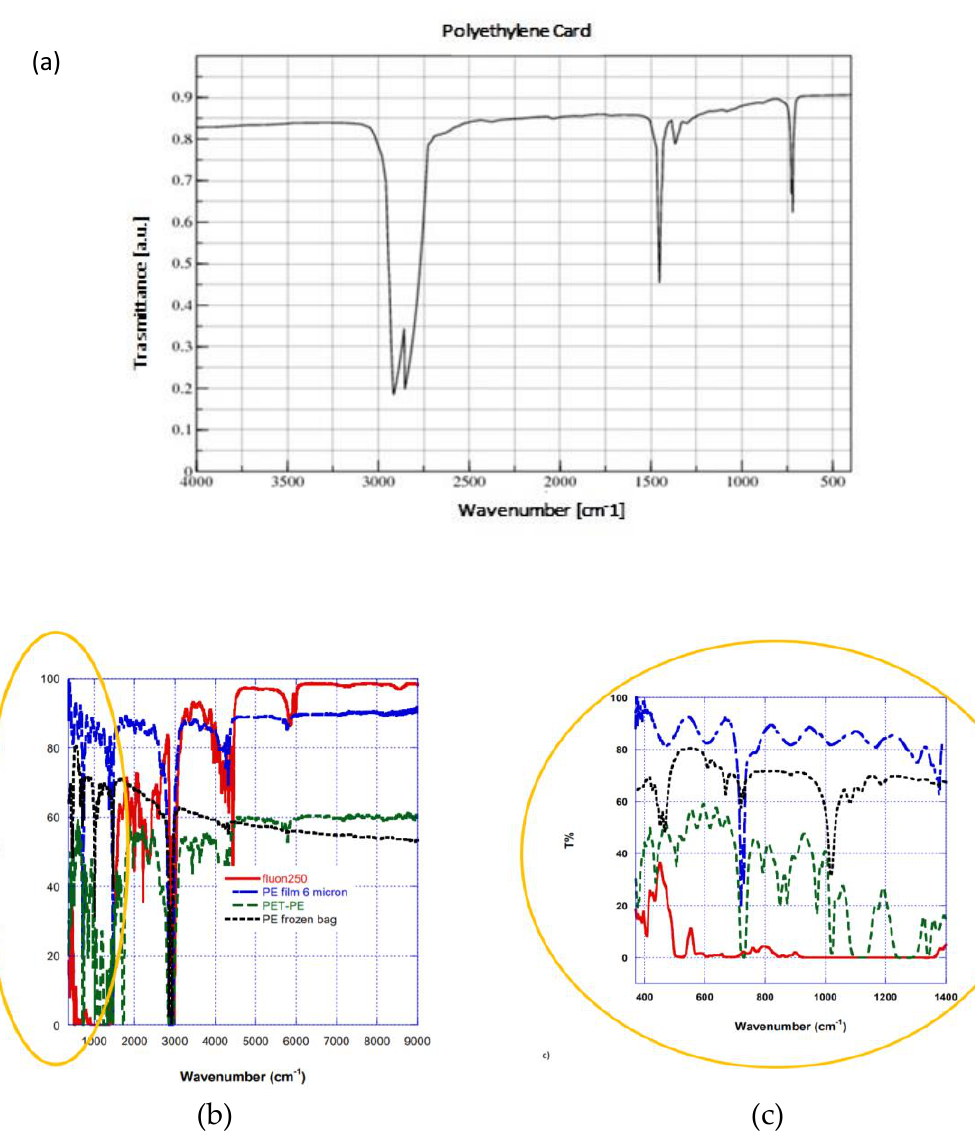
Figure 7. FTIR transmittance spectra of different polymeric thin films for selecting cover material. (a) Book spectrum of polyethylene card; (b) full range spectra of Fluon 250 (red line), PE film 6 micron thick (blue line), PET-PE (green line), PE based freezer bag (dark line). (c) Insert containing the interest region (769–1250 cm -1 ), where the most transparent polymer is the blue-one line.